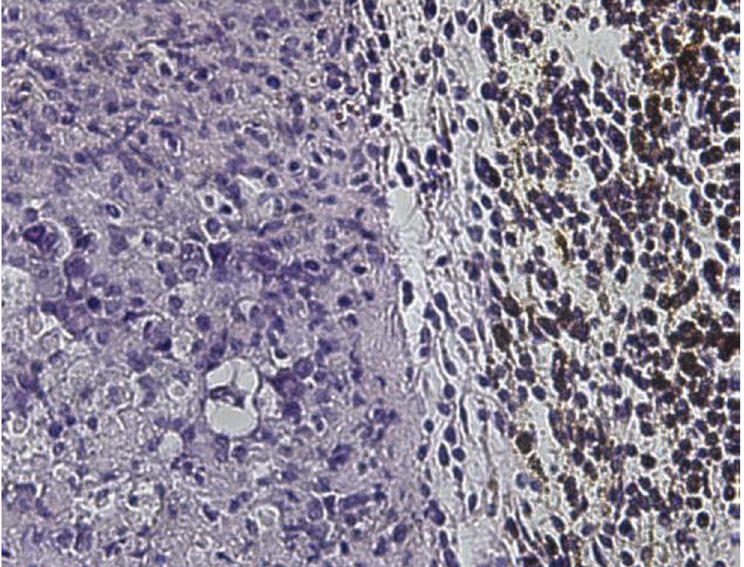
Figure 8. This histological section demonstrates significant mNP accumulation in per-tumoral mac- rophages following EcPHL vaccination and mNP administration 24 h post mNP intratumor injec-